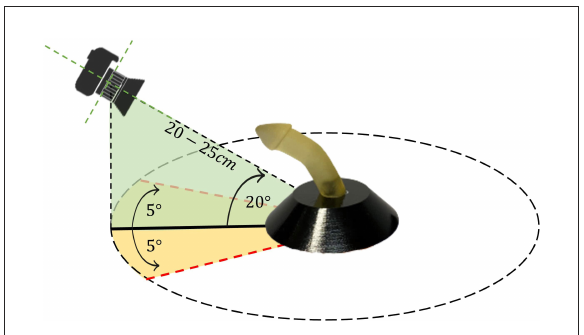
FIGURE2 Experimental set-up for model image